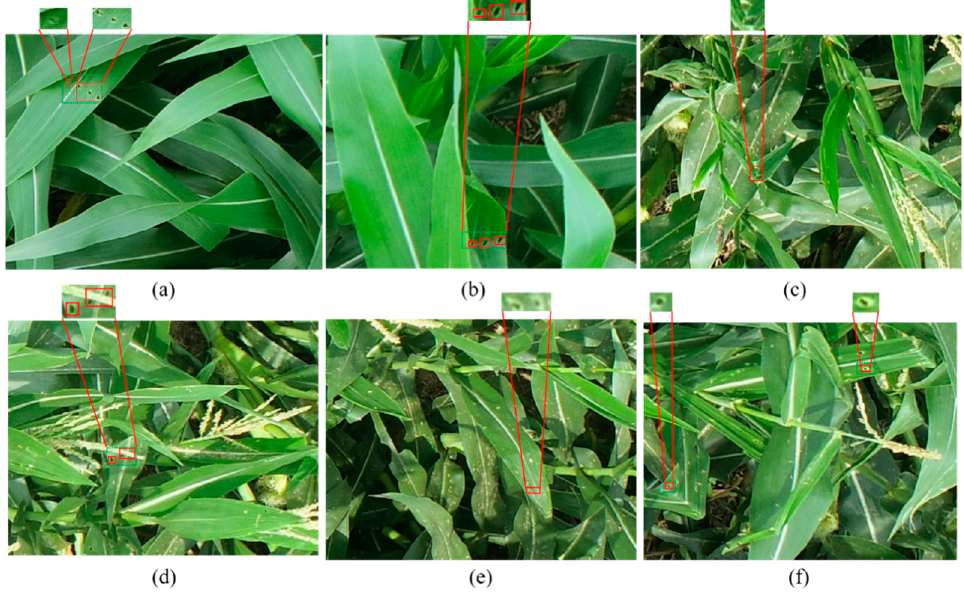
Figure 2. Example pictures showing detection difficulties; ( a , b ) The characteristics of pest regions of corn in V12 stage; ( c – f ) The characteristics of pest regions of corn in VT stage.